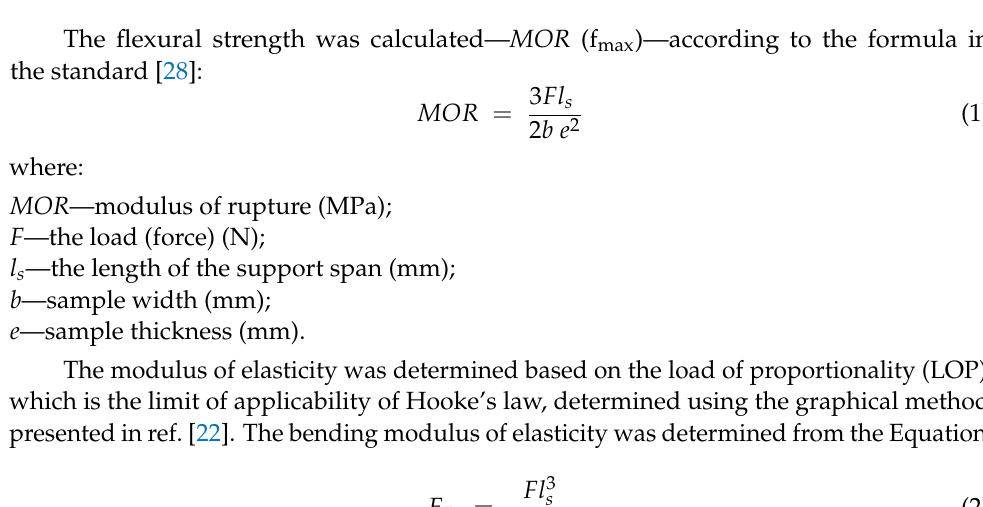
Figure 12. Graph showing MOR of front facade samples compared to reference samples.